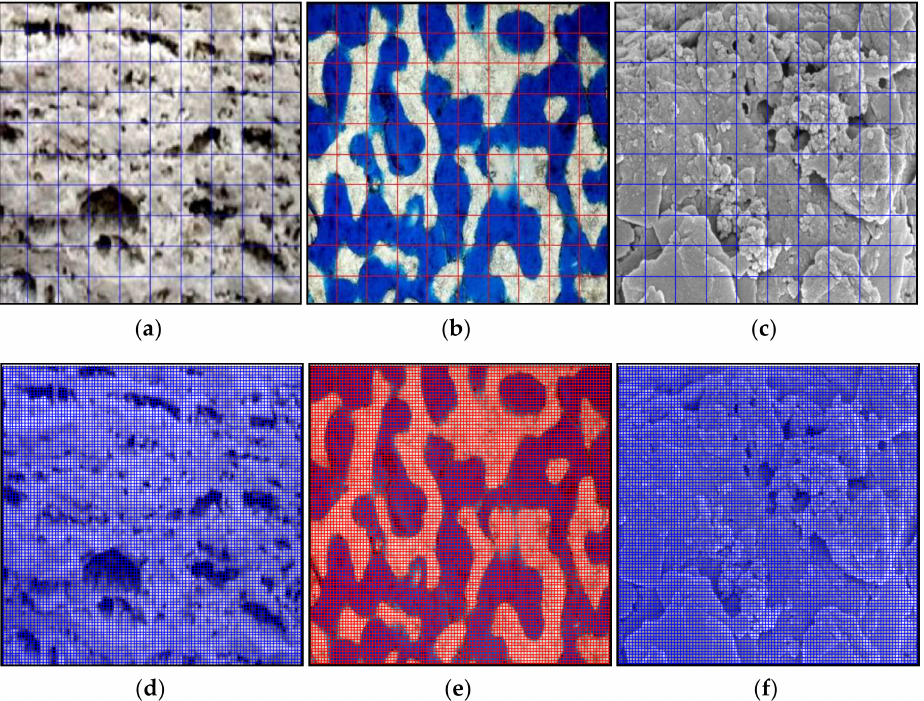
Figure 13. Grid division of multi-scale pore structure image. ( a ) 10 × 10 macro-image; ( b ) 10 × 10 mesoscopic image; ( c ) 10 × 100 micro-image; ( d ) 100 × 100 macro-image; ( e ) 100 × 100 mesoscopic image; ( f ) 100 × 100